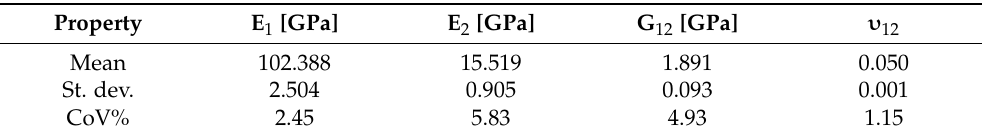
Table 3. Average material properties from three successive optimization runs. These values were used in the remainder of the